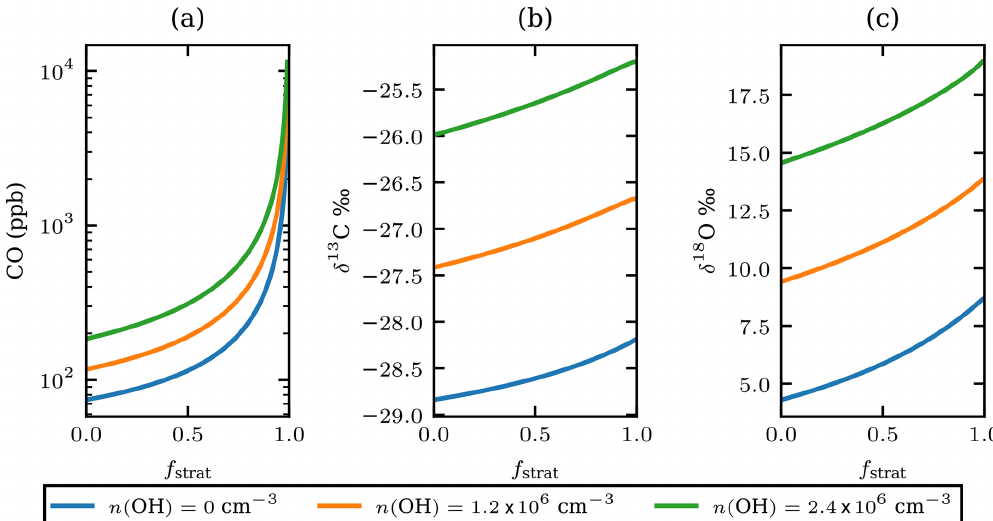
Figure 5. The estimated CO mole fractions on a logarithmic scale (a) , the carbon (b) , and oxygen (c) isotopic composition of the plume CO for different OH number densities versus f strat just after injection into the stratosphere. OH number densities are shown in the legend; the value of 1 . 2 × 10 6 can be considered representative of the stratosphere. The value of 2 . 4 × 10 6 is arbitrarily added as twice the stratospheric value and serves as an upper estimate.